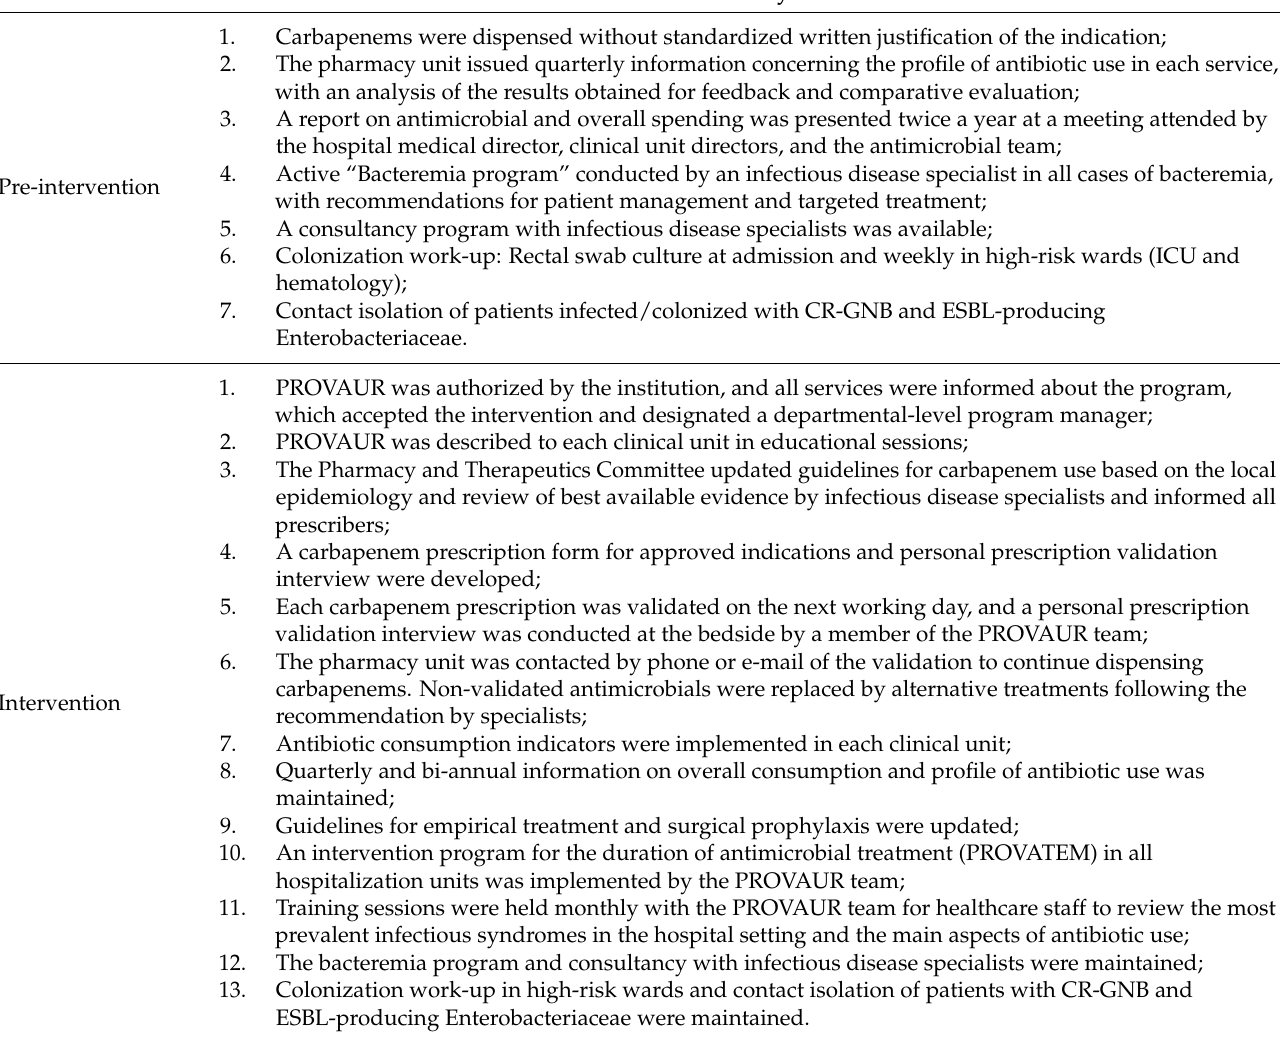
Table 6. Measures carried out before and during the program for the Validation of Guidelines for Restricted-Use Antibiotics (PROVAUR